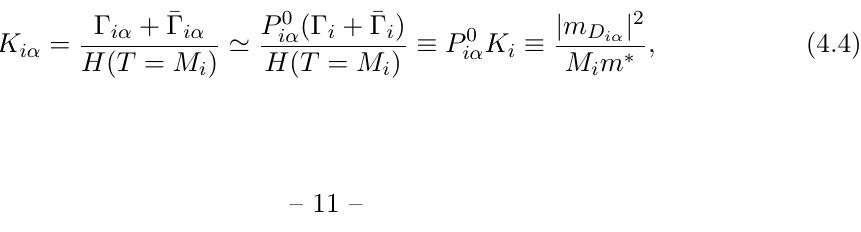
-leptogenesis over 2